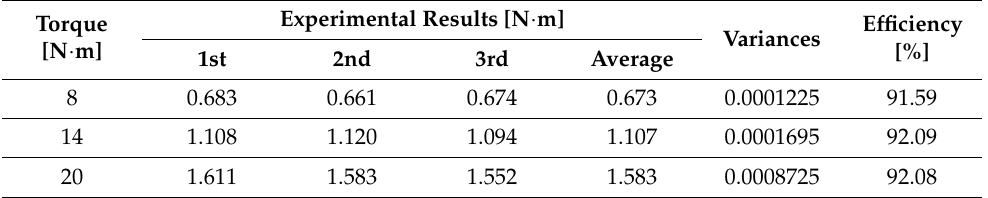
Table 7. Experimental results for first gear set.